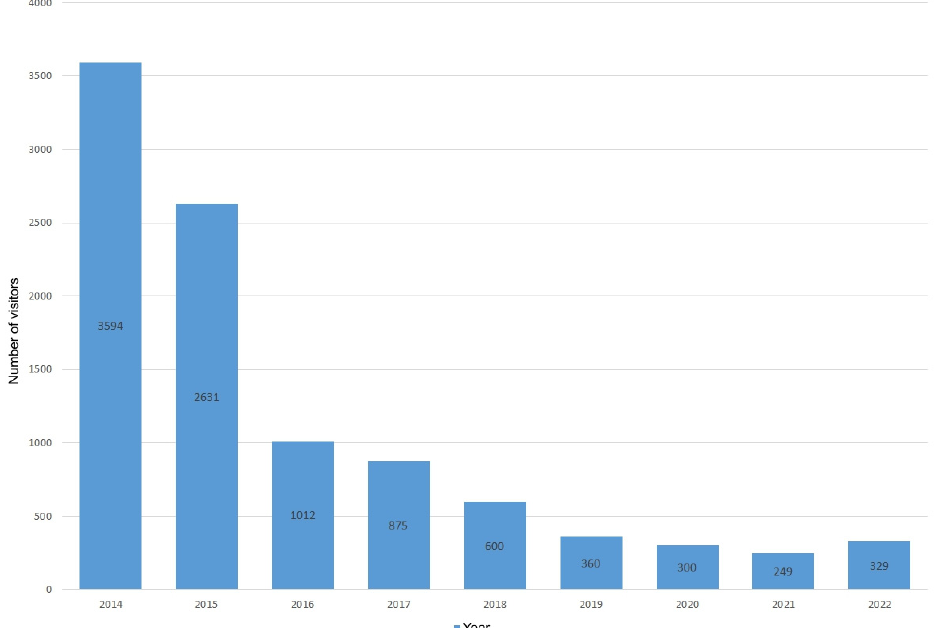
Figure 5. The number of visits for the virtual globe collection in 2014–2022. Source: Map Collection of the Faculty of Science, Charles University.